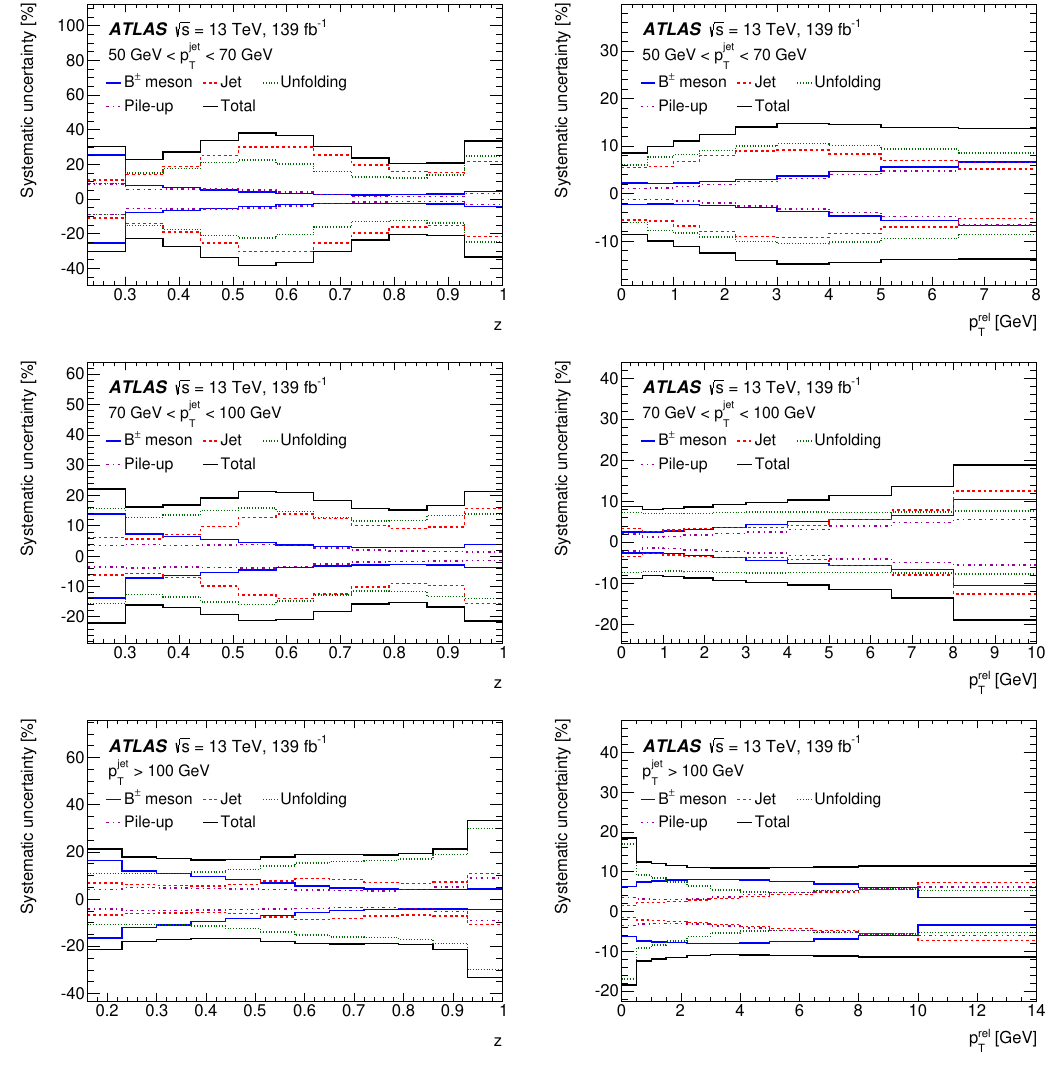
Figure 5 . Systematic uncertainties as a function of z for all jet- p T bins (left) and as a function of for all jet- p bins p rel T T